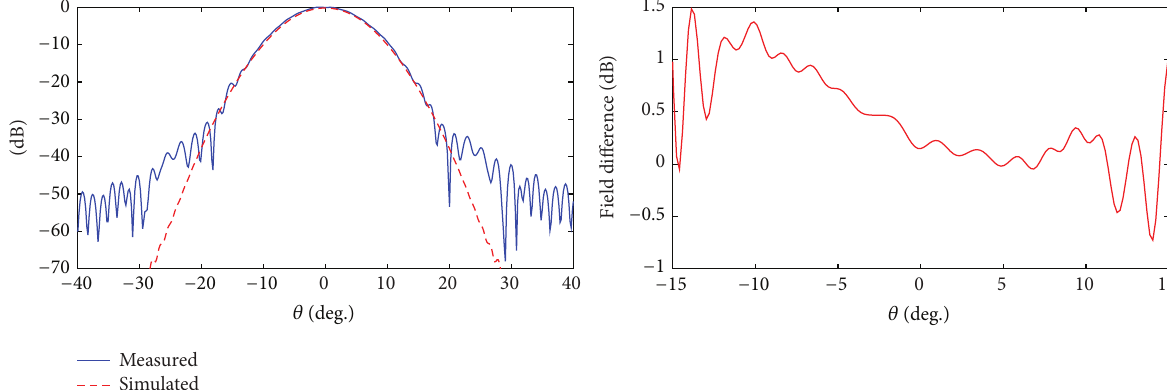
Figure 15: Calculated and simulated far field patterns of the 183 GHz channel on vertical